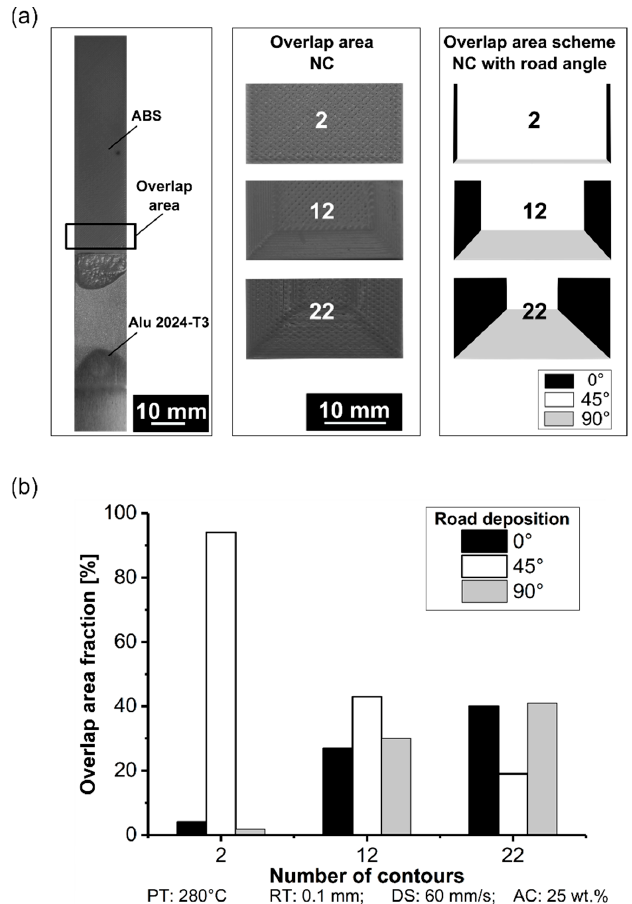
Figure 21. Correlation with the overlap area and road deposition angle on the aluminum 2024 ‐ T3/ABS hybrid joints ( a ) schematic, ( b ) overlap area fraction (condition nine, NC: 2; condition ten, NC: 12; condition eleven, NC: 22; the following parameters PT: 280 °C, RT: 0.1 mm, DS: 60 mm/s, and AC: 25 wt.% were fixed for the conditions investigated).